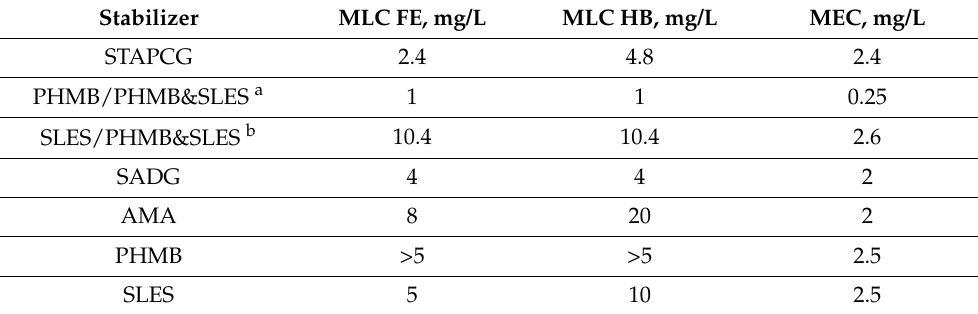
Table 2. Effects of stabilizers on sea urchin embryos.